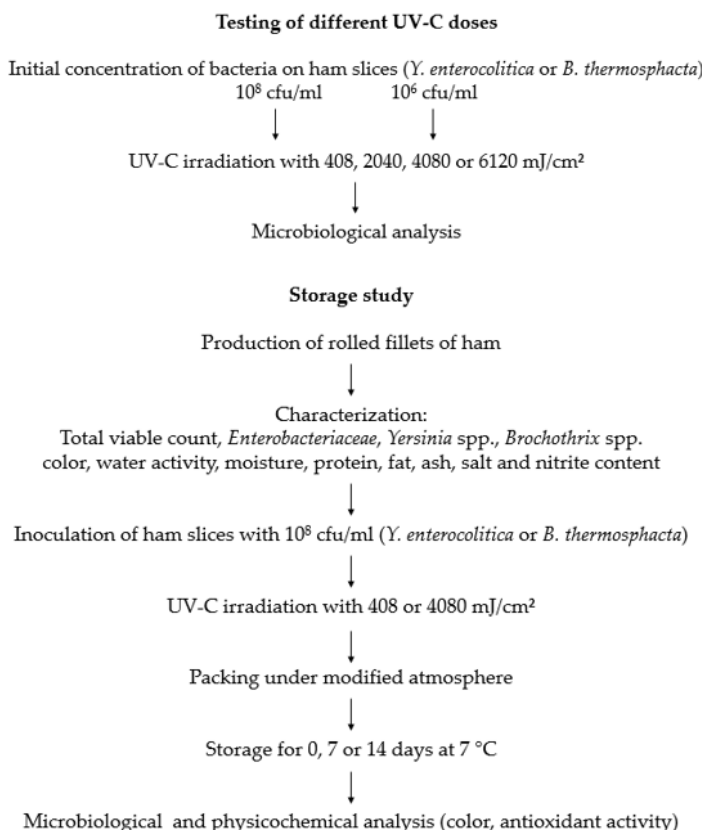
Figure 1. Overview of the experiments performed in the present study. 2.5. Material For the analysis of the dose dependent bacterial reduction, slices of rolled fillets of ham of the type of an air dried ham from five different batches of the same brand were purchased from a local supermarket. Additionally, three different batches of the ham were purchased to analyze whether photoreactivation occurs. Each package contained 100 g ham slices, packaged in polypropylene under modified atmosphere. The sales designation is low fat (maximum 2% fat) cured rolled fillet of